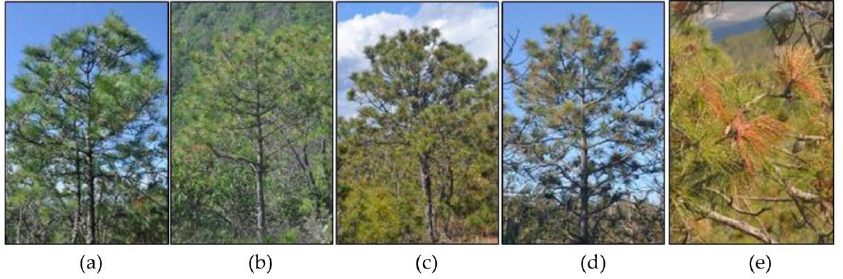
Figure 2. Example of di ff erent levels of damage trees. ( a ) Healthy tree. ( b ) Slightly infested tree. ( c ) Moderately infested tree. ( d ) Severely infested tree. ( e ) Damaged shoots. Table 2. Levels 1–4 of damaged Yunnan pines based on the tree shoot damage ratio (SDR).